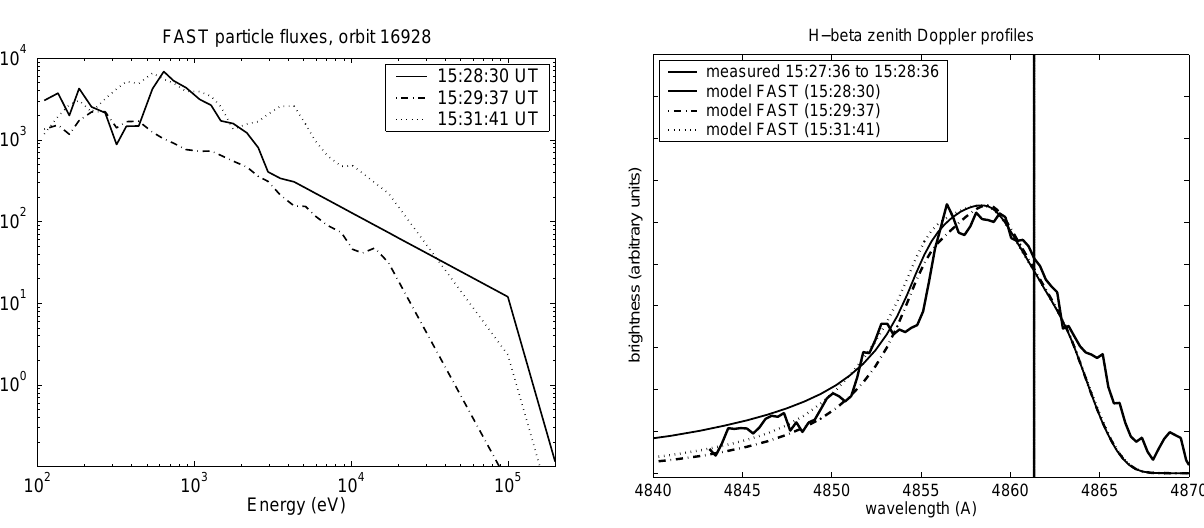
Fig. 11. FAST input particle flux with high energy extrapolation. Fig. 12. Comparison of measured profile with modeled profiles